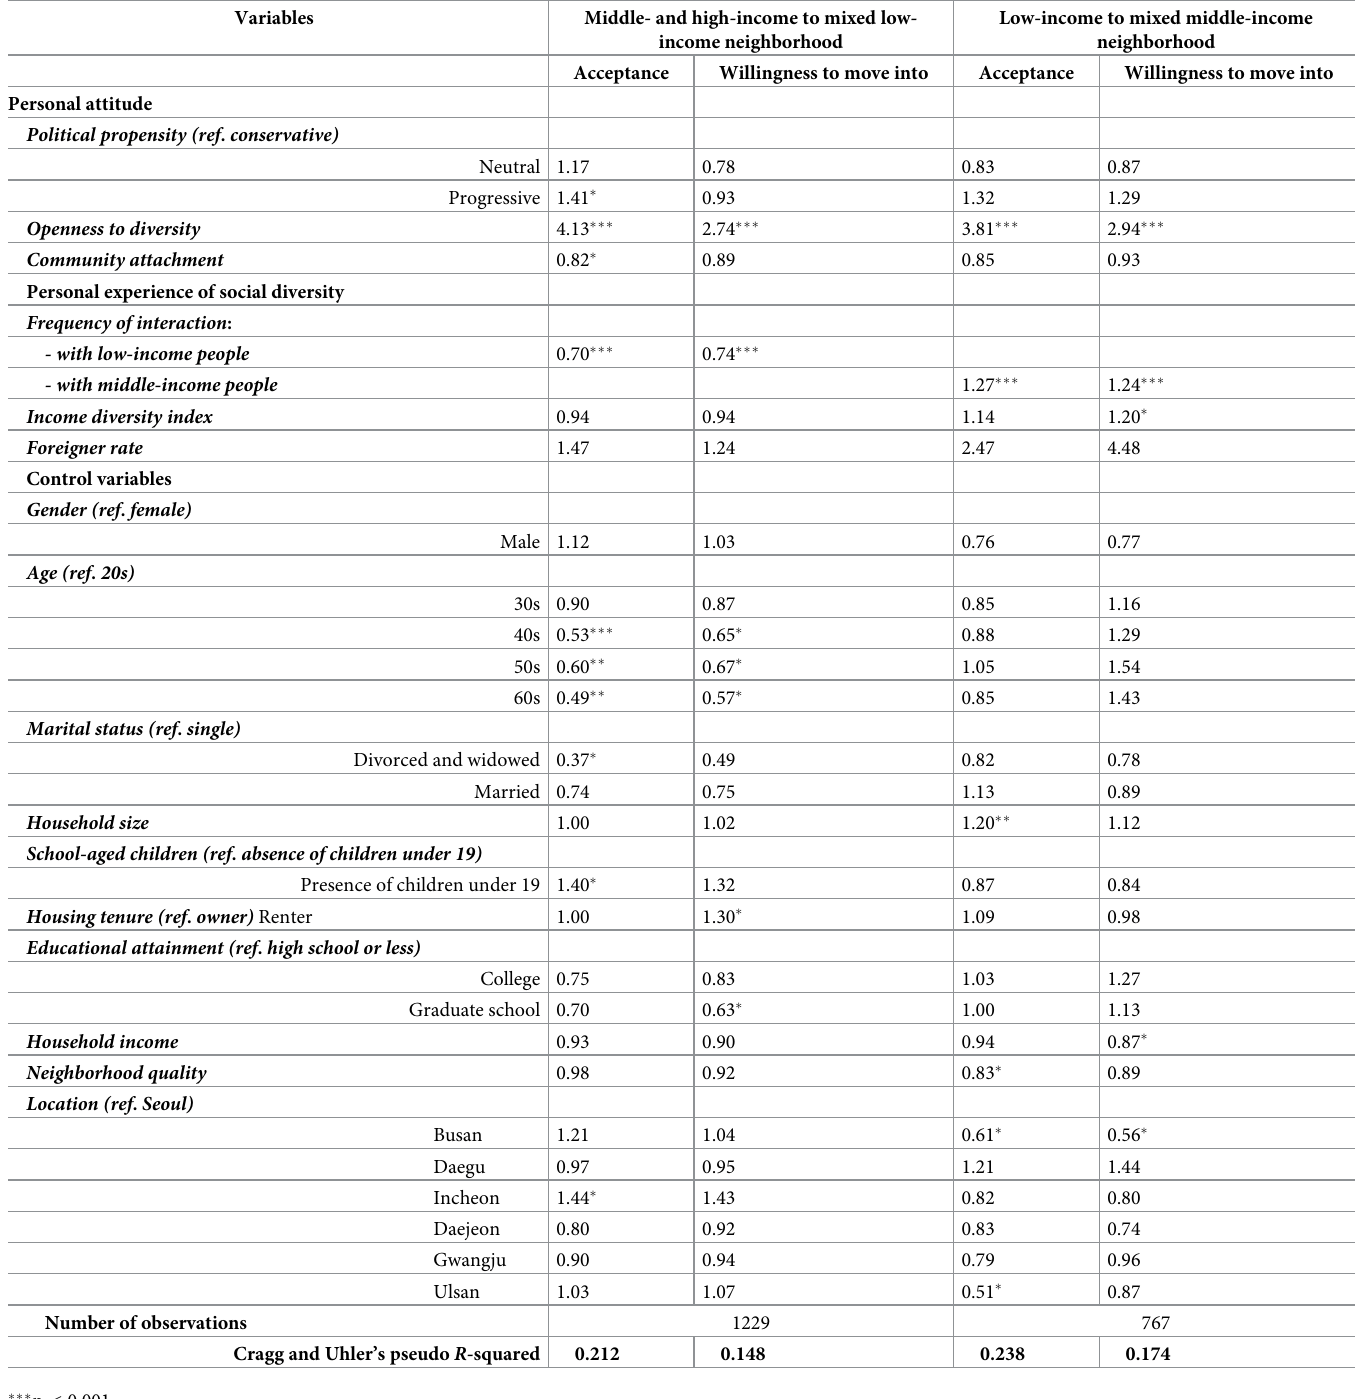
Table 3. Results of ordinal logistic regression (odds